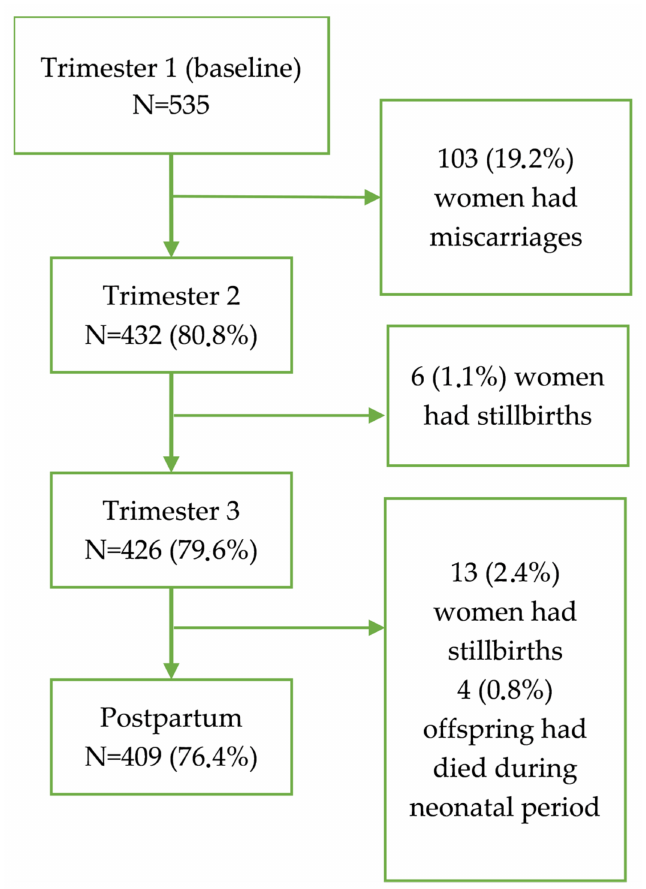
Figure 1. Flow chart of women who were followed up from the first trimester to postpartum and reasons for